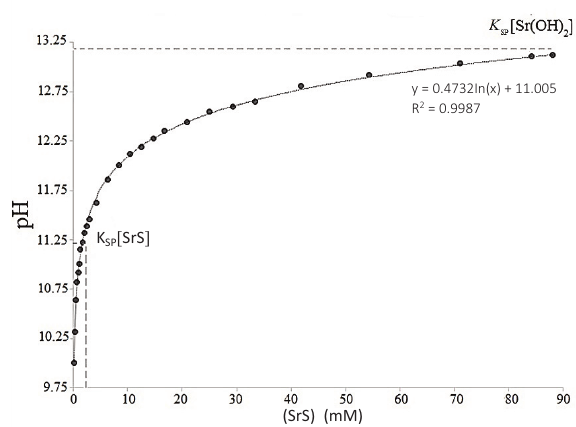
Fig. 2. Measured and calculated pH values of SrS aqueous solutions (in the [SrS] range of 0.125−88.064 mM), where the vertical dashed lines refer to the solubility points which cor ­ respond to the measured values of K SP,SrS and K SP,Sr(OH)2 [12,32].